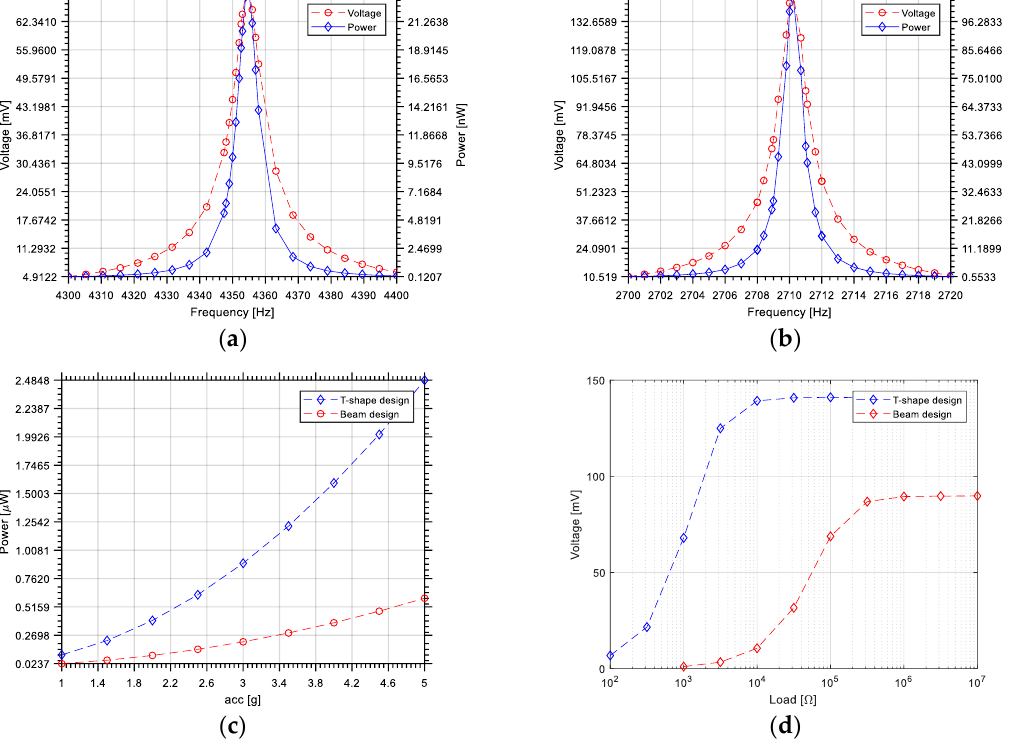
Figure 9. Simulation of the frequency response of the proposed design without using the substrate as a proof mass: ( a ) output voltage and power of the reference beam design; ( b ) output voltage and power of the T-shaped optimized design; ( c ) output power of the designs vs. acceleration; and ( d ) output voltage vs. resistive load value for both